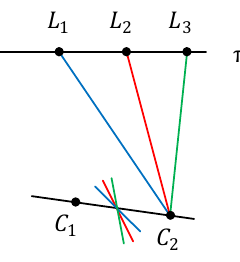
Figure 3. C 1 and C 2 are two viewpoints (camera center) on the baseline. Lines L 1 , L 2 , and L 3 Figure 3. (cid:10) and (cid:10) are two viewpoints (camera center) on the baseline. Lines (cid:8) (cid:11) (cid:13) thogonal to this page) are coplanar on the plane π. Their associated planes all intersect at a charac- (orthogonal to this page) are coplanar on the plane π . Their associated planes all intersect at a teristic line (orthogonal to this page) through the baseline [14]. characteristic line (orthogonal to this page) through the baseline